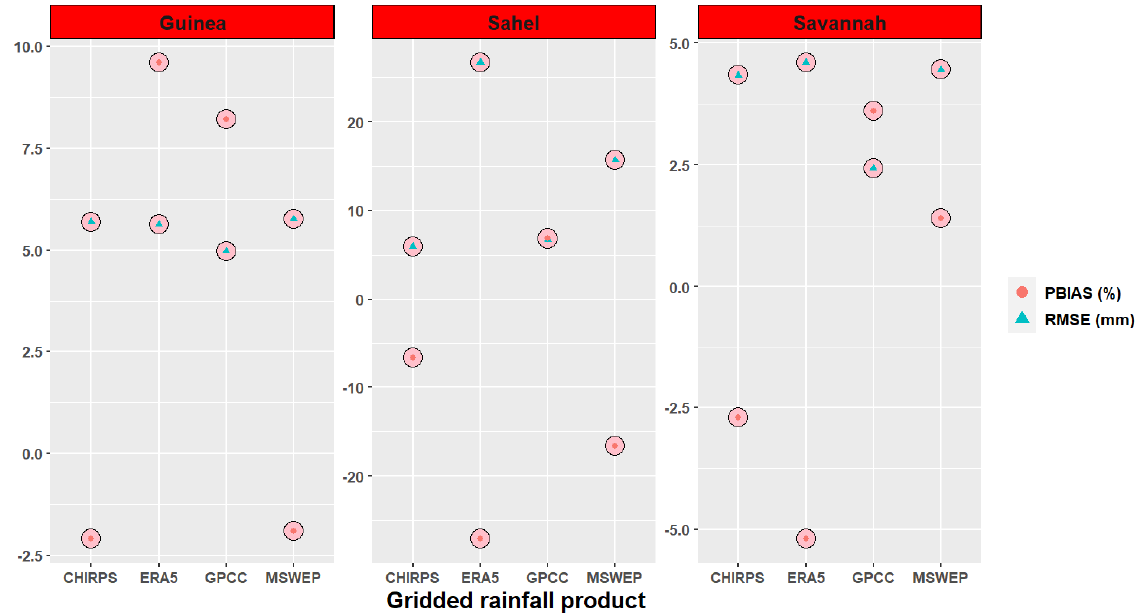
Figure 6. Mean annual cycle over the Sahel, Savannah, and Guinea coast region.